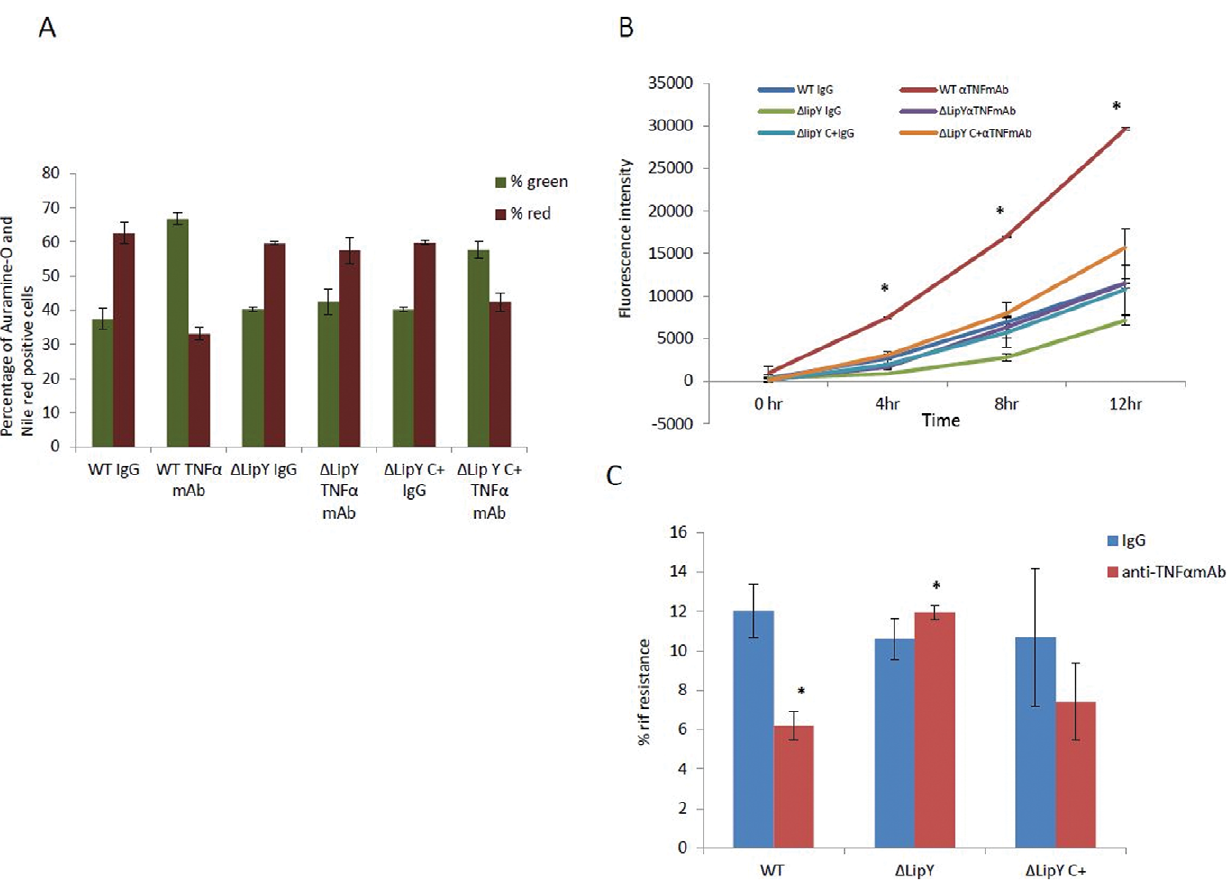
Figure 8. Deletion of lipY compromised the ability of Mtb to reactivate upon treatment with anti-TNF a mAb. ( A ) Auramine-O and Nile red staining of WT and D -lip Y mutant and D -lip Y complemented strain ( D -lip Y C + ) population in in vitro grown granuloma. ( B ) Alamar Blue readouts at different time intervals when WT and D -lip Y, and D -lip Y C + Mtb cells from granulomas treated with anti-TNF- a antibody or control IgG, were incubated with Alamar blue dye. (data of one representative data set has been displayed.) ( C ) D -lip Y mutant from granulomas treated with IgG or anti-TNF- a antibody had a higher antibiotic resistance as compared to WT Mtb cells from anti-TNF- a antibody treated granulomas. Data are presented as mean + / 2 SEM from 3 experiments. P values were calculated using students t test. *p ,